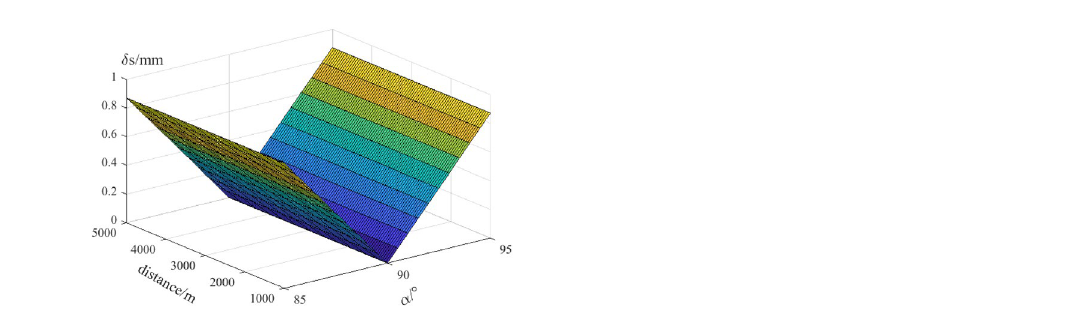
Figure 5. The river-crossing distance measurement using the static GNSS method.